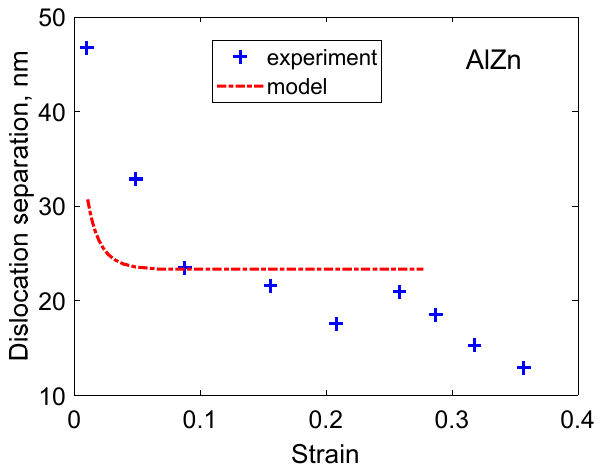
Figure 4. Dislocation separation in the subgrain boundaries versus strain for Al5Zn at 250 °C and 16 MPa. Experimental data from [2,29].